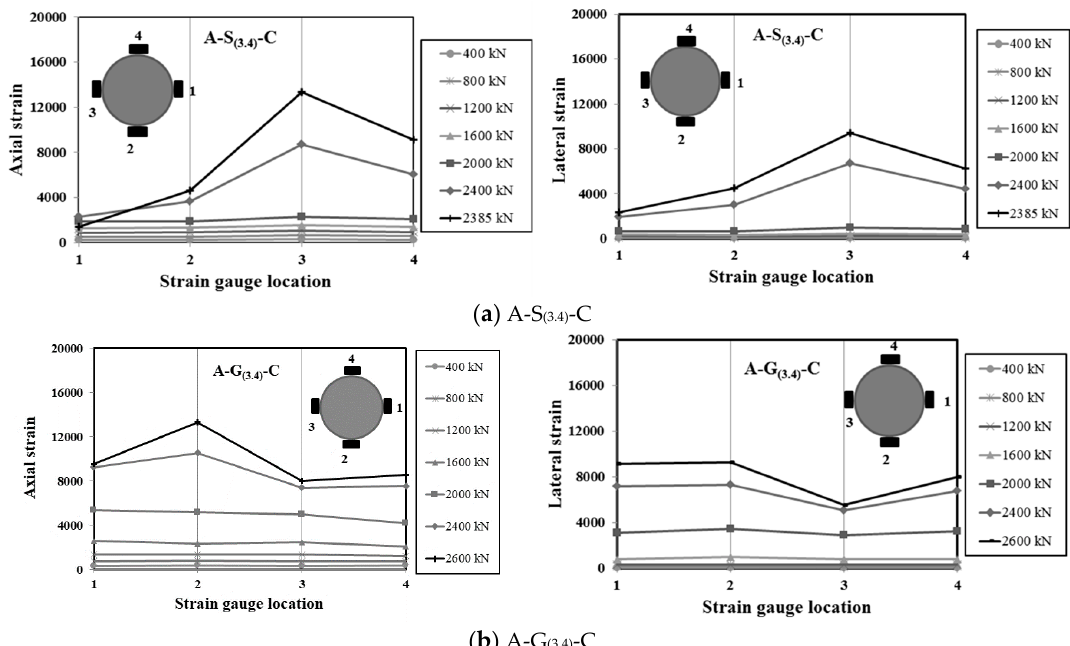
Figure 10. Strain distribution versus different strain gauges locations surrounding the column perimeter at the mid-height for specimen: ( a ) A-S (3.4) -C; ( b ) A-G (3.4) -C.